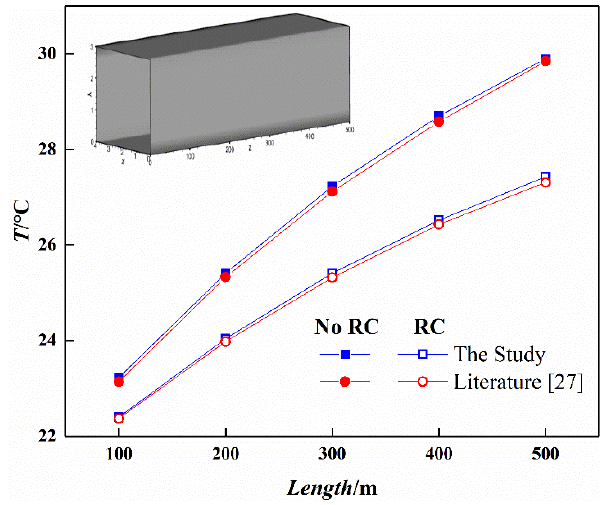
Figure 5. Comparison of simulation and literature results.